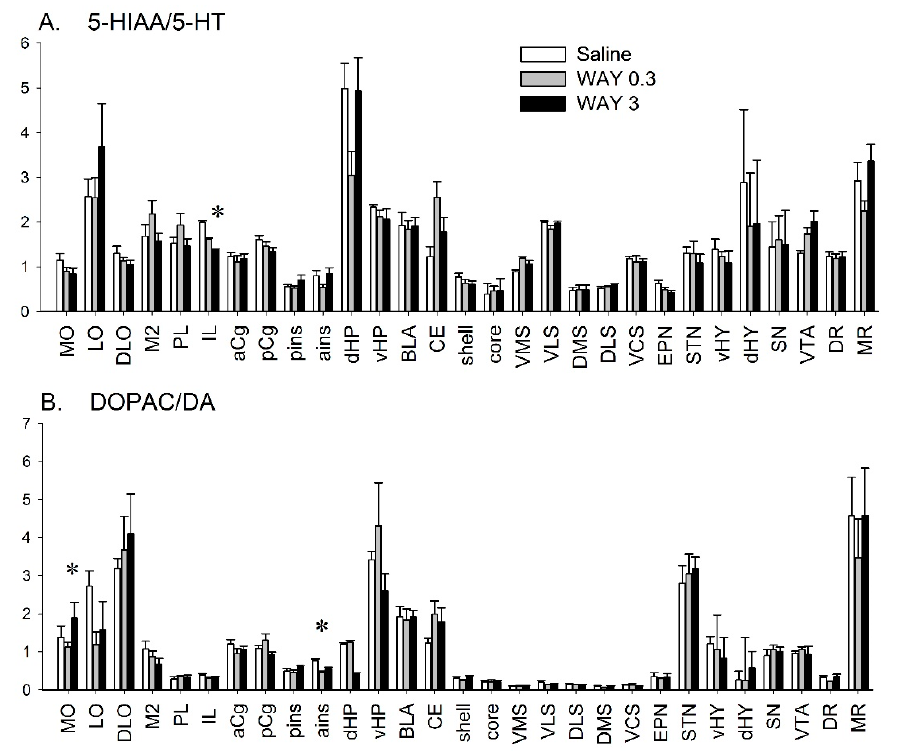
Figure 1. E ff ect of WAY-163909 on turnover of 5-HT (5-HIAA / 5-HT ratio) ( A ) and DA (DOPAC / DA ratio) ( B ) across rat brain regions. The left, medial, and right panels correspond to saline-, WAY-163909 0.3 mg / kg, and 3 mg / kg treated rats, respectively. The results correspond to the mean ± SEM of the ratios in 29 di ff erent brain regions. WAY-163909 or saline has been intraperitoneally (i.p.) administered, and the tissue values correspond to 45 minutes after the administration. Data for DA and 5-HT tissue contents used in this experiment have been already reported [29]. WAY-163909’s e ff ects have been compared to saline-treated rats using a one-way ANOVA. The number of values considered has been reported in Table S1. * p < 0.05 with respect to the saline treatment group (protected least significant difference (PLSD) test).